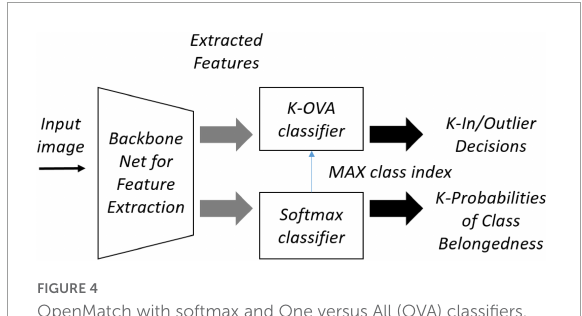
FIGURE4 OpenMatch with softmax and One versus All (OVA)